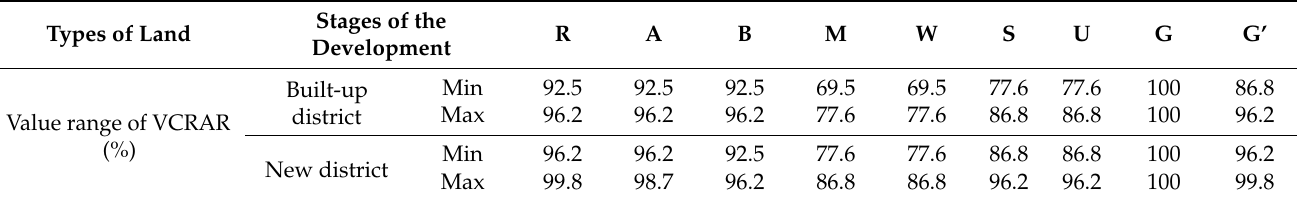
Table 4. The value range of VCRAR for every type of land